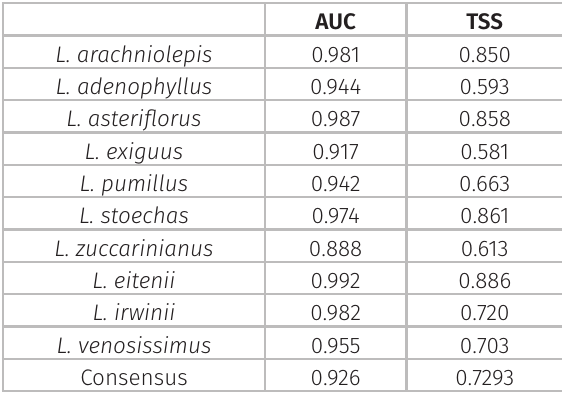
Table II. AUC and TSS validation values of current modeling of Lessingianthus